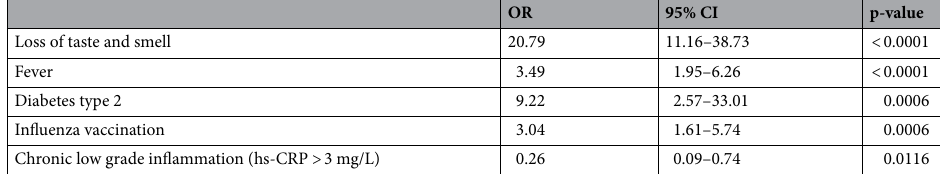
Table 2. Stepwise analyses of symptoms and occurrence of SARS-CoV-2-specific antibody positivity. OR odds ratio, CI confidence interval, hs‑CRP high-sensitivity C-reactive protein.